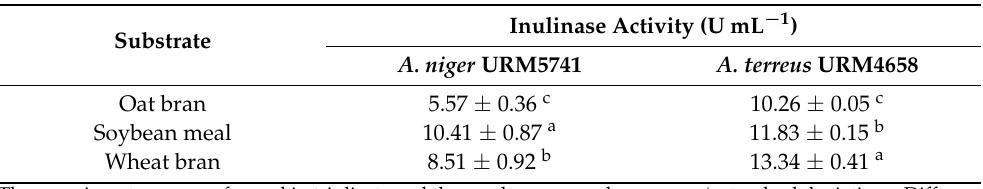
Table 2. Inulinase production by Aspergillus niger URM5741 and Aspergillus terreus URM4658 after 72 h of solid-state fermentation using different agro-industrial substrates.